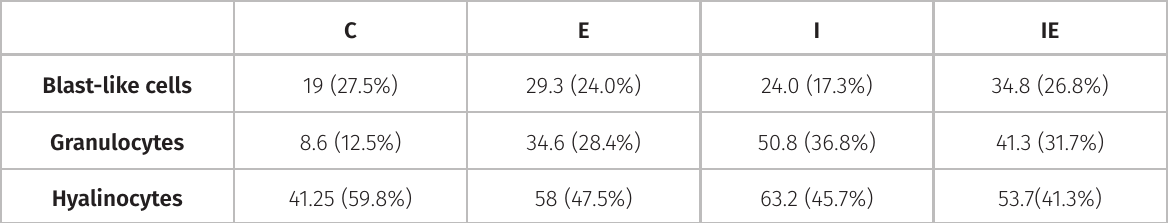
Table I. Effect of the E uphorbia milii latex exposure on the types of hemocytes in the uninfected and infected Biomphalaria glabrata by Schistosoma mansoni . Data are mean